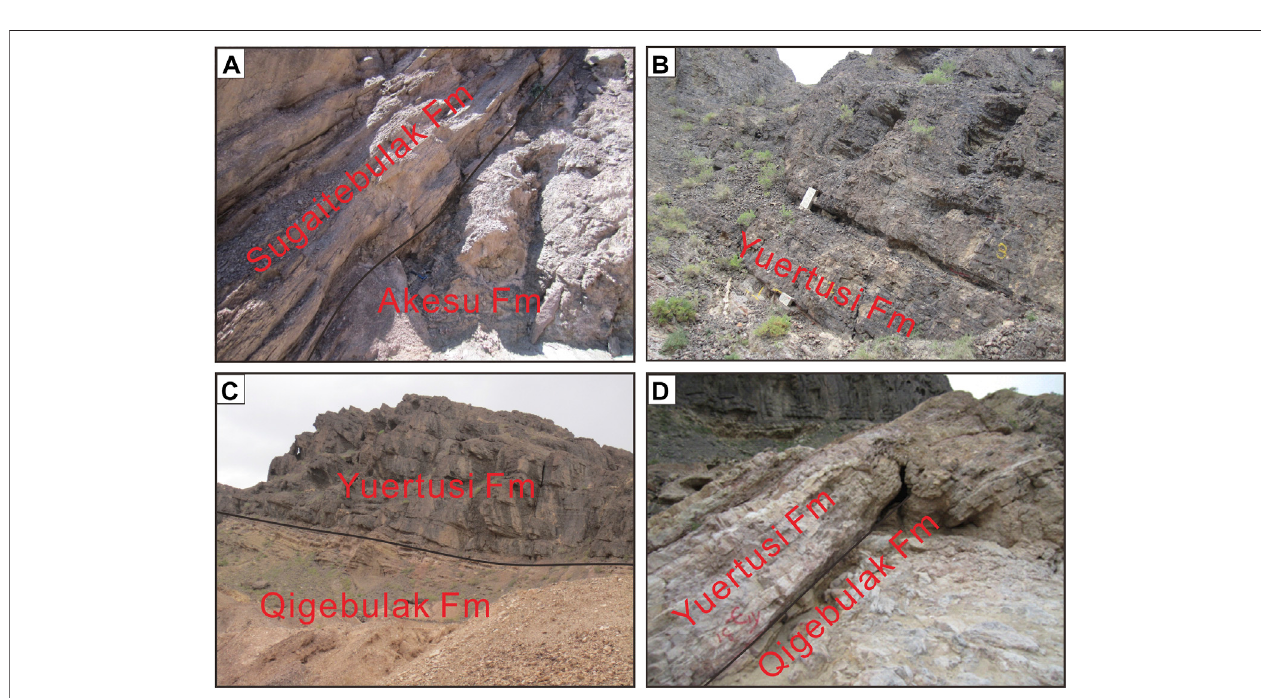
FIGURE 8 | Field photographs of the Sinian – Cambrian boundary (the SCB) in the Aksu region ( Figure 3 for locations). (A) Aksu and Sugaitebulak formations; (B) Yuertusi Formation; (C) Yuertusi and Qigebulak formations; (D) Yuertusi and Qigebulak formations.